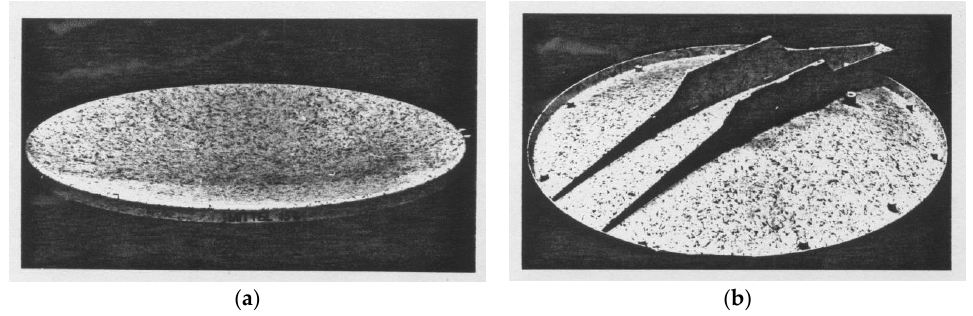
Figure 1. Satellite dish with 15 wt % of Sheet Molding Compound (SMC): ( a ) front view; ( b ) reverse view.